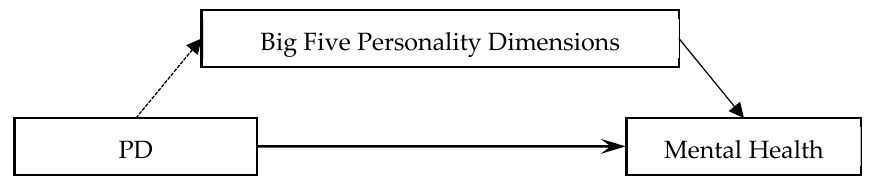
Figure 1. Hypothesis model. Note: PD denotes total differences for parental parenting styles.